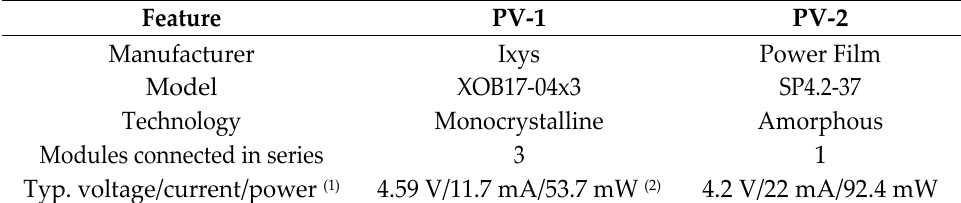
Table 1. Features of the commercial low-power PV